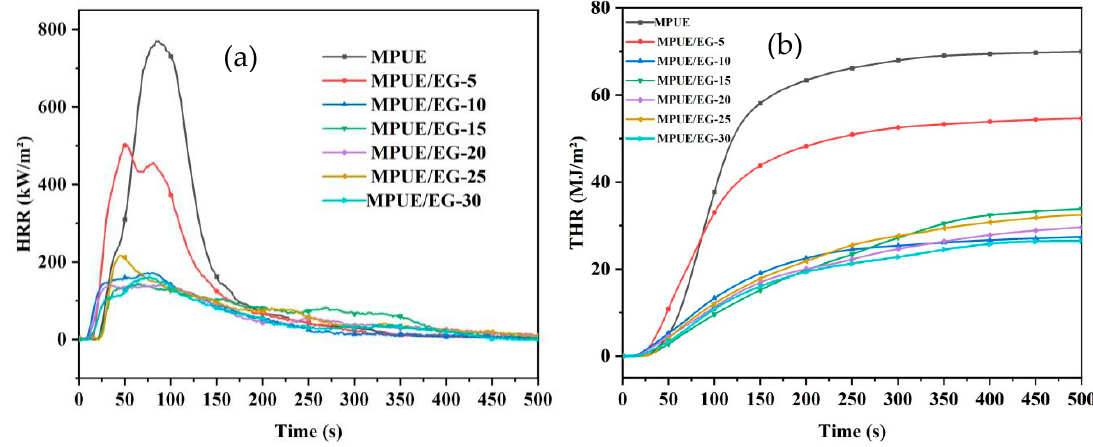
Figure 11. ( a ) HRR and ( b ) THR curves of MPUE/EG. As we know, smoke can be highly toxic and corrosive, and this cannot be ignored once a fire has started. Therefore, SPR and TSR were important indices for evaluating the combustion properties of materials. As shown in Figure 12, there were two peaks at 0.072 m 2 /s and 0.055 m 2 /s on the SPR curve of the neat MPUE, corresponding to two stages of its thermal decomposition. The SPR curve of MPUE incorporated with 5 wt% EG also displayed two peaks at 0.070 m 2 /s and 0.043 m 2 /s, which was similar to that of the neat MPUE. This indicates that a small amount of EG has no obvious effect of inhibiting smoke. When the EG content was 10 wt%, PSPR was 0.016 m 2 /s, which was only 22% of that of MPUE. There was only one peak at the SPR curve. This indicates that the introduction of EG greatly inhibited the generation of flue gas, and flue gas release was significantly slowed down during the whole combustion process. For higher EG content (>10 wt%), the trend of the SPR curve was basically consistent with that of MPUE/EG-10 (10 wt% of EG). However, the PSPR value did not significantly decrease with increasing EG content. Compared to the neat MPUE, the TSR of MPUE/EG-5 (5 wt% of EG) was decreased by only 10%. For MPUE/EG-10 (10 wt% of EG) and MPUE/EG-20 (20 wt% of EG), the corresponding TSR values were drastically decreased, by 75% and 89%,